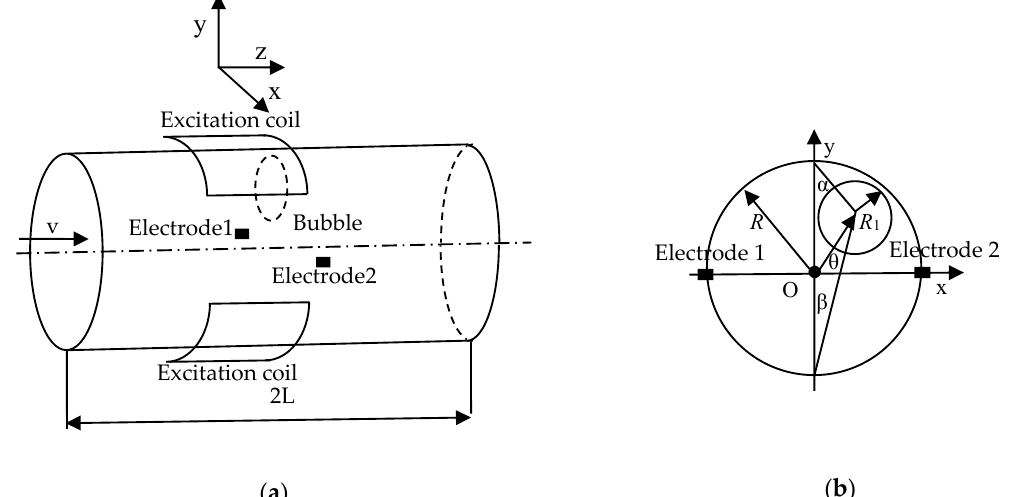
Figure 1. Thestructureoftheelectromagneticflowmeter. ( a )Three-dimensionDiagram; ( b Figure 1. The structure of the electromagnetic flowmeter.